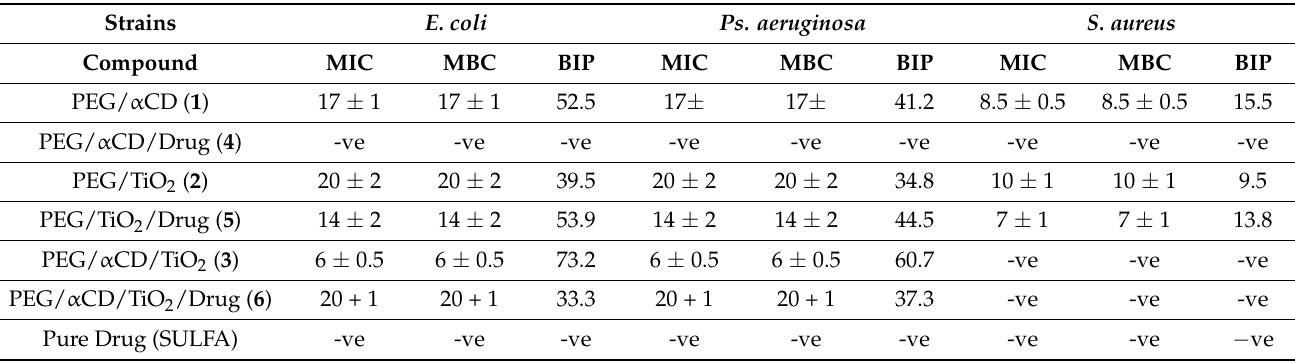
Table 7. Comparison of the antimicrobial effect of sulfaguanidine before and after loading to prepared polymers versus some Gram-negative and Gram-positive